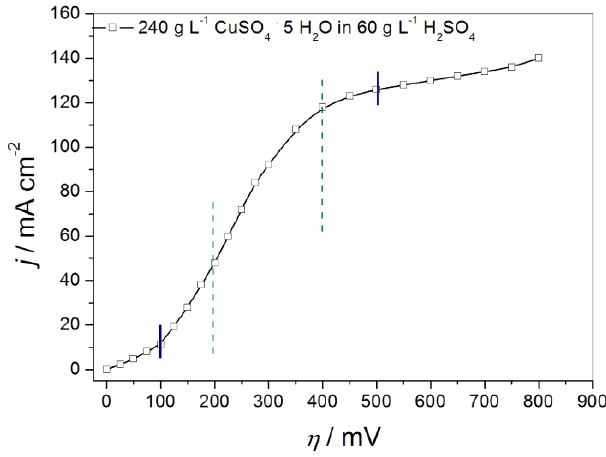
− 1 CuSO · 5H · L − 1 H 4 2 O in 60 g 2 SO 4